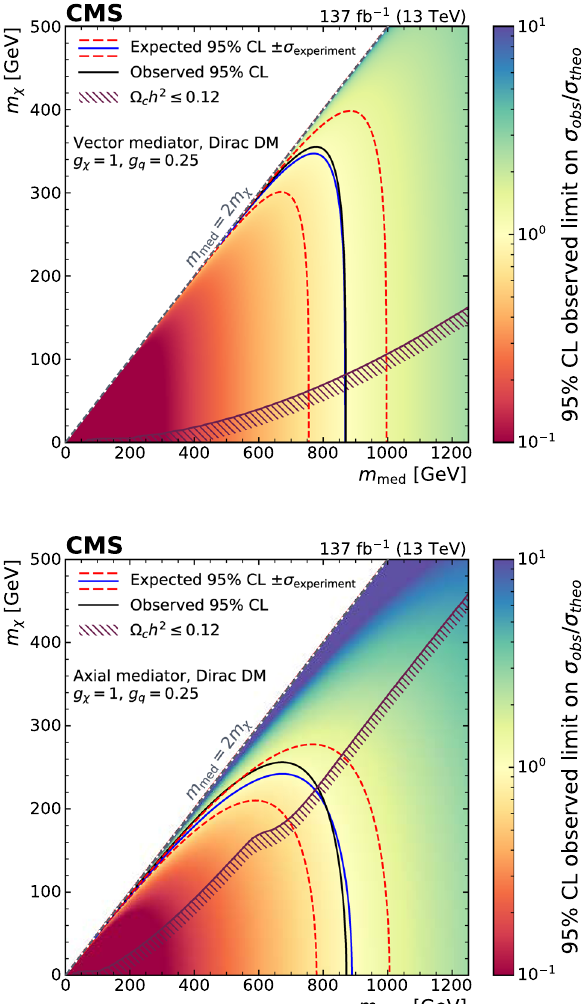
Fig. 5 The 95% CL exclusion limits for the vector (upper) and the axial-vector (lower) simplified models. The limits are shown as a func- tion of the mediator and DM particle masses. The coupling to quarks is fixed to g q = 0 . 25 and the coupling to DM is set to g χ =